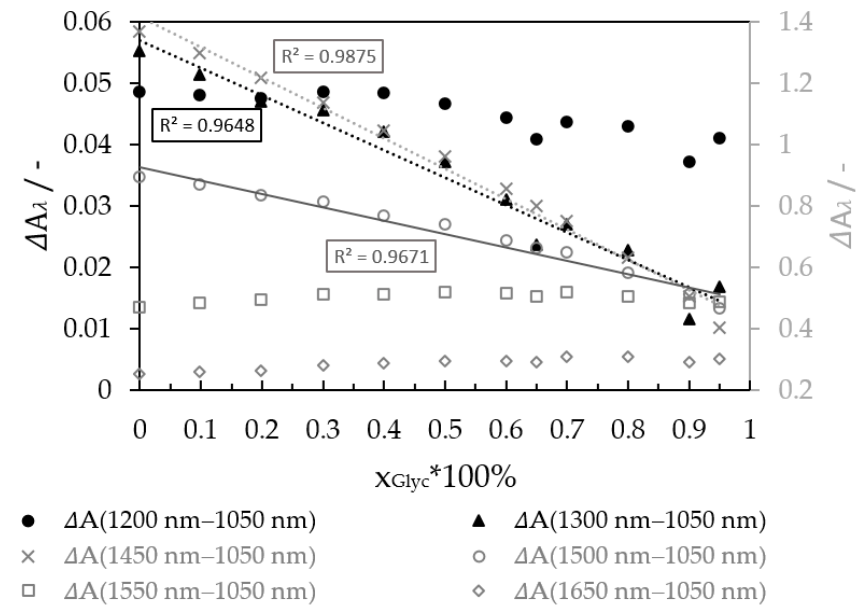
Figure 5. Differences between absorbance by wavelength and the reference 1050 nm.